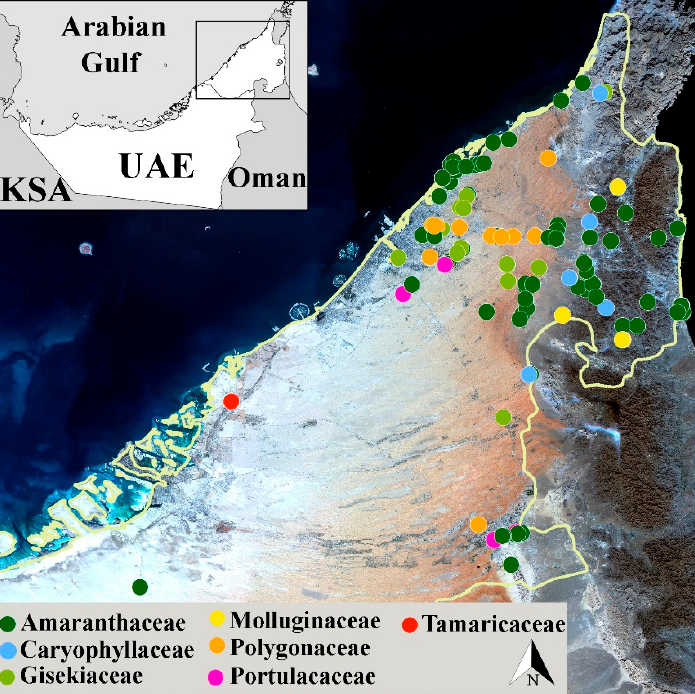
Figure 1. Map showing collection sites of plant samples for DNA barcoding and seed bank collections.